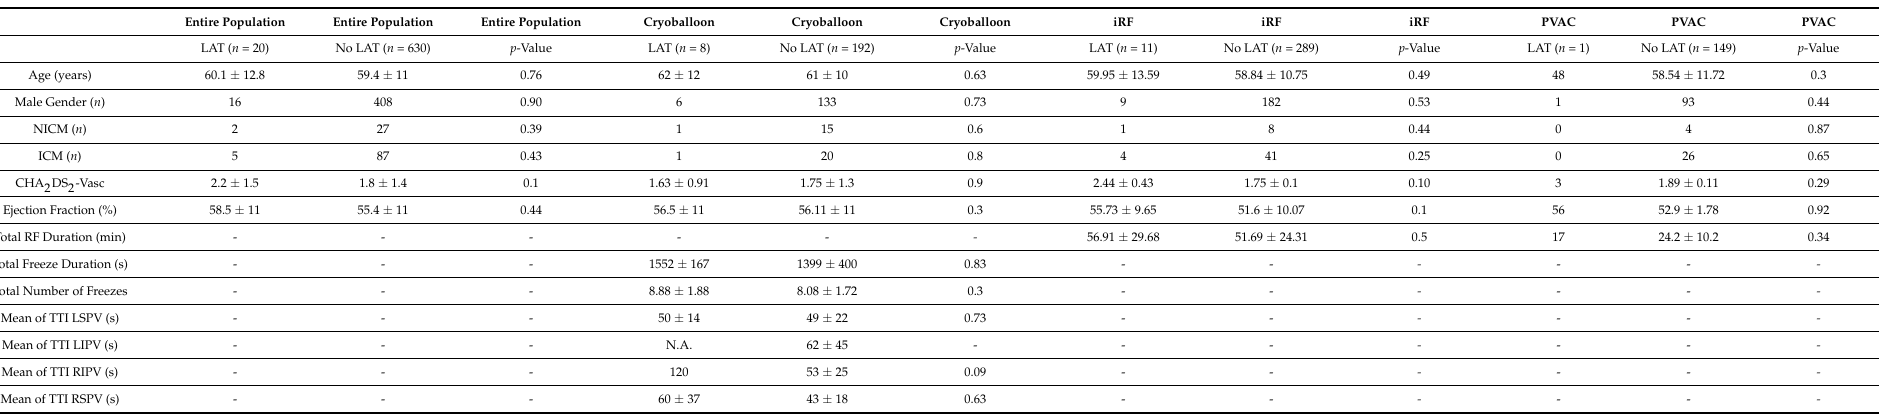
Table 3. Univariate analysis of possible LAT predictors for the entire population, as well as the cryoballoon, iRF and PVAC populations (NICM: non-ischemic cardiomyopathy; ICM: ischemic cardiomyopathy; RF: radiofrequency; LSPV: left superior pulmonary vein; LIPV: left inferior pulmonary vein; RIPV: right inferior pulmonary vein; RSPV: right superior pulmonary vein; TTI: time to